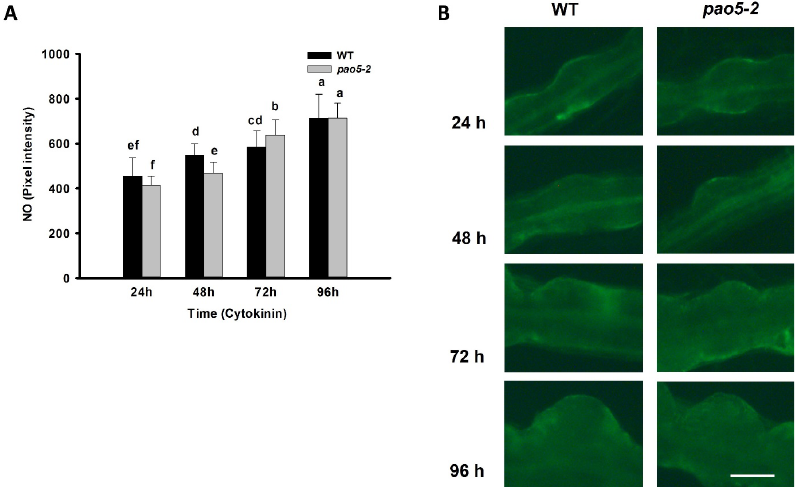
Figure 6. Detection of NO-dependent fluorescence of DAF-FM DA-stained wild-type (WT) and pao5-2 mutant roots after 24, 48, 72, and 96 h cytokinin induction representing the mitotic pause (24 h), organ conversion (48 h), early (72 h) and late (96 h) promeristem phases of shoot meristem re- generation. ( A ) Pixel intensity of the LRPs stained with the fluorescent dye. Data are means ± SE of three biological replicates with twenty technical replicates each. The significance of the difference between samples was analysed by one-way analysis of variance (ANOVA) following Duncan’s mul- tiple range tests; p -values of less than 0.05 were considered significant. Different letters indicate sig- nificant differences. ( B ) Visualization of NO-dependent DAF-FM DA fluorescence during the direct conversion of lateral root primordia to shoot meristem using fluorescence microscopy. Scale bar = 100 µm. Exogenous application of the NO donor GSNO to the roots during the conversion stage (in parallel with cytokinin) significantly decreased the relative expression of AtPAO5 (already from 24 h cytokinin induction onward) and the shoot regeneration effi- ciency (Figure 7). Therefore, uncontrolled NO accumulation might act negatively on the regeneration process upstream of AtPAO5.